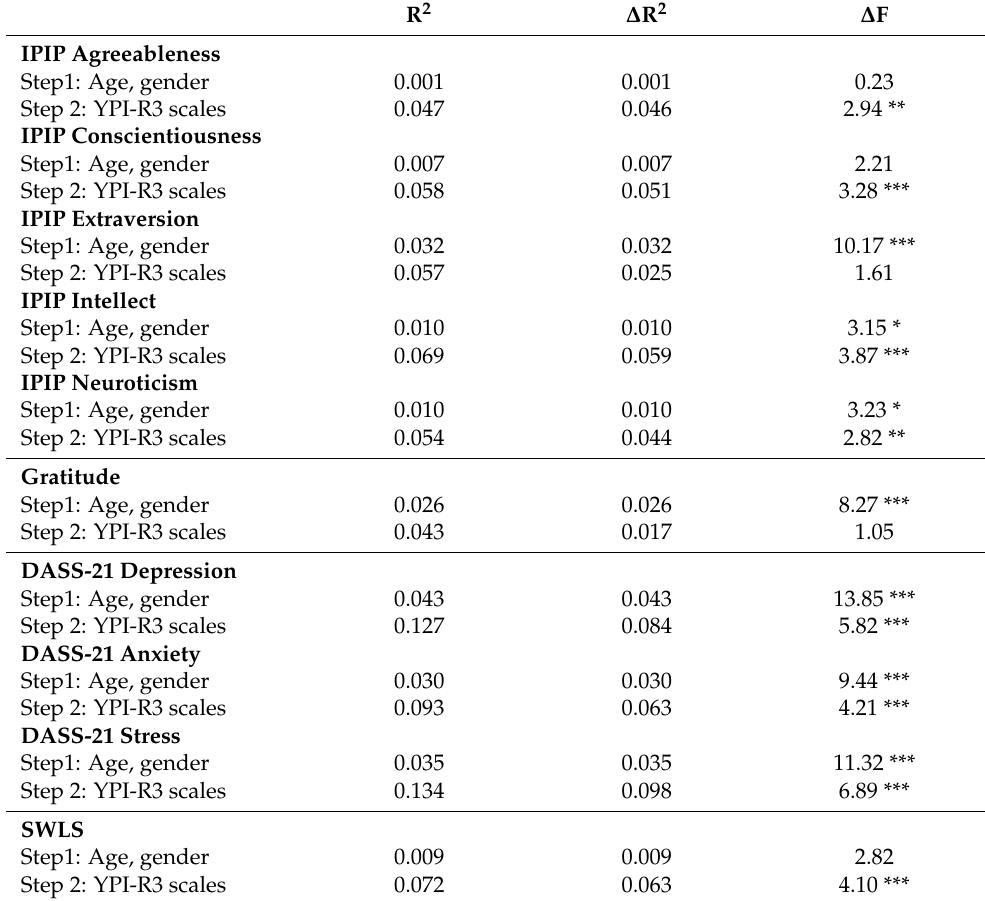
Table 9. Hierarchical regression analysis of the YPI-R3 predicting the IPIP, Gratitude, DASS-21, SWLS and Humor scales using the Singapore mothers’ sample ( n =